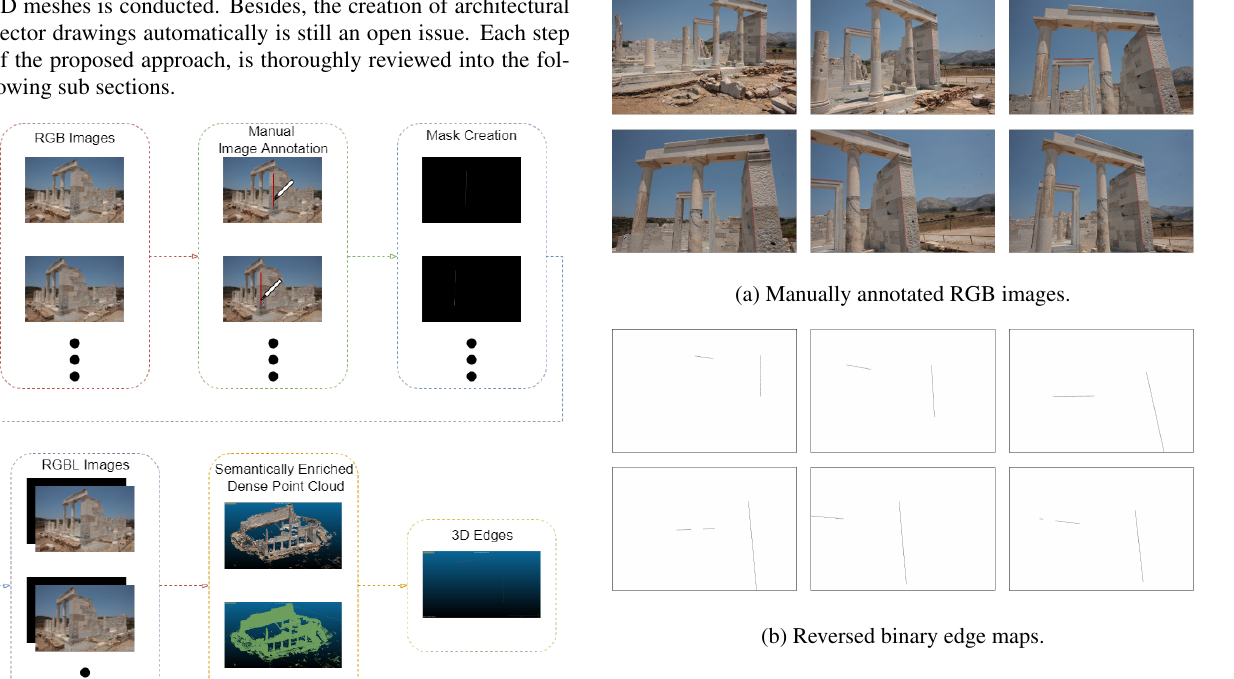
Figure 3. Manually annotated RGB images and binary edge